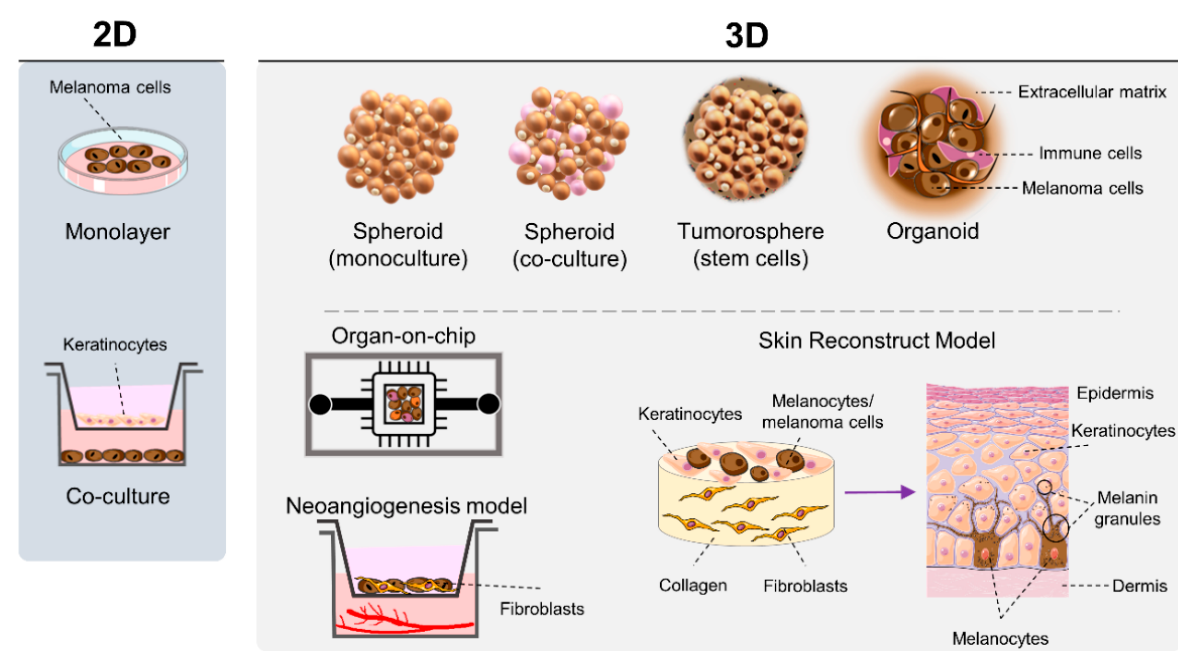
Figure 3. Schematic representation of the main in vitro models used for melanoma research. Part of the figure was drawn by using pictures from Servier Medical Art. Servier Medical Art by Servier is licensed under a Creative Commons Attribution 3.0 Unported License (https://creativecommons.org/licenses/by/3.0/ (accessed on 25 June 2021)).